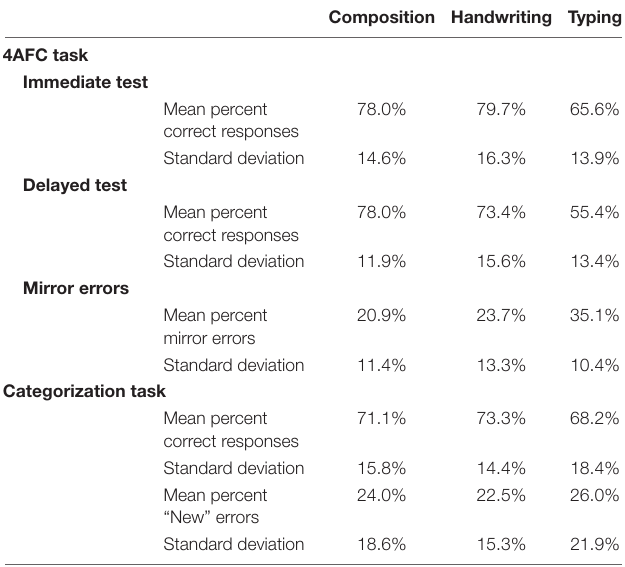
TABLE 1 | Performance for both recognition tasks across learning